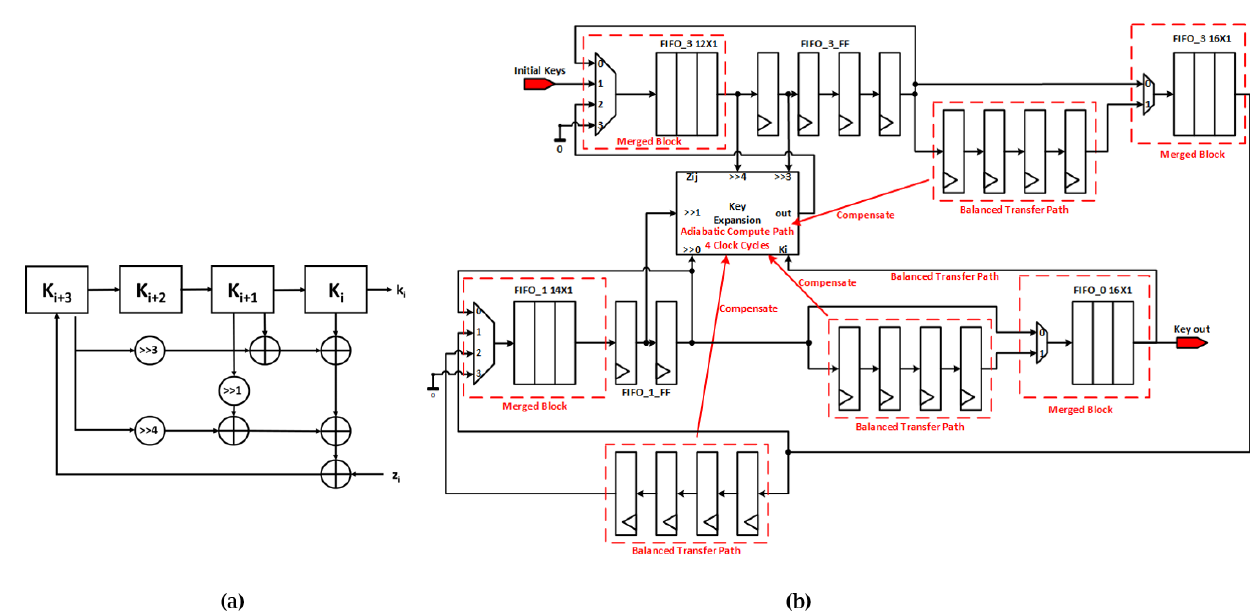
Figure 3. SIMON32/64 key expansion: ( a ) block-level diagram of the algorithm, ( b ) implementation of the key expansion in the adiabatic SIMON architecture, illustrating the merged blocks and balanced transfer